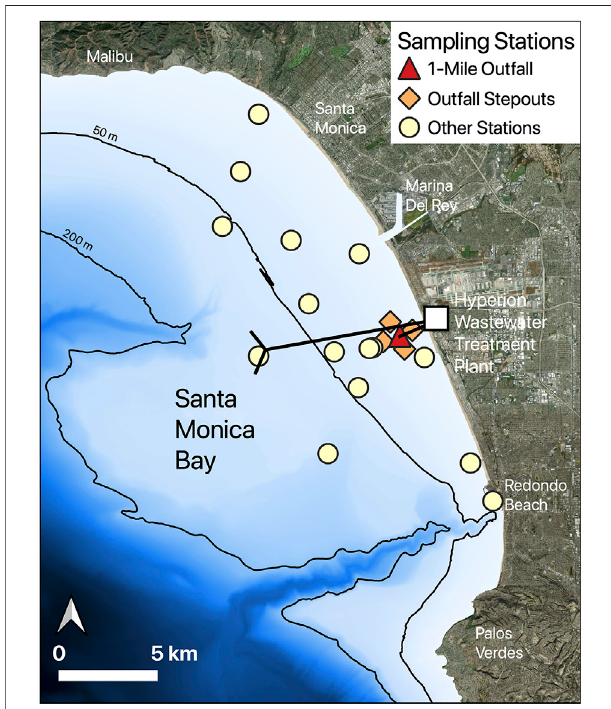
FIGURE 1 | Map of Santa Monica Bay with the sampling stations including the 1-mile outfall station (D9W, red triangle), the stepout stations surrounding the outfall (orange diamonds), and the other stations (yellow circles). The 1-mile and 5-mile outfall pipes extending from the Hyperion Wastewater Treatment Plant are represented by black